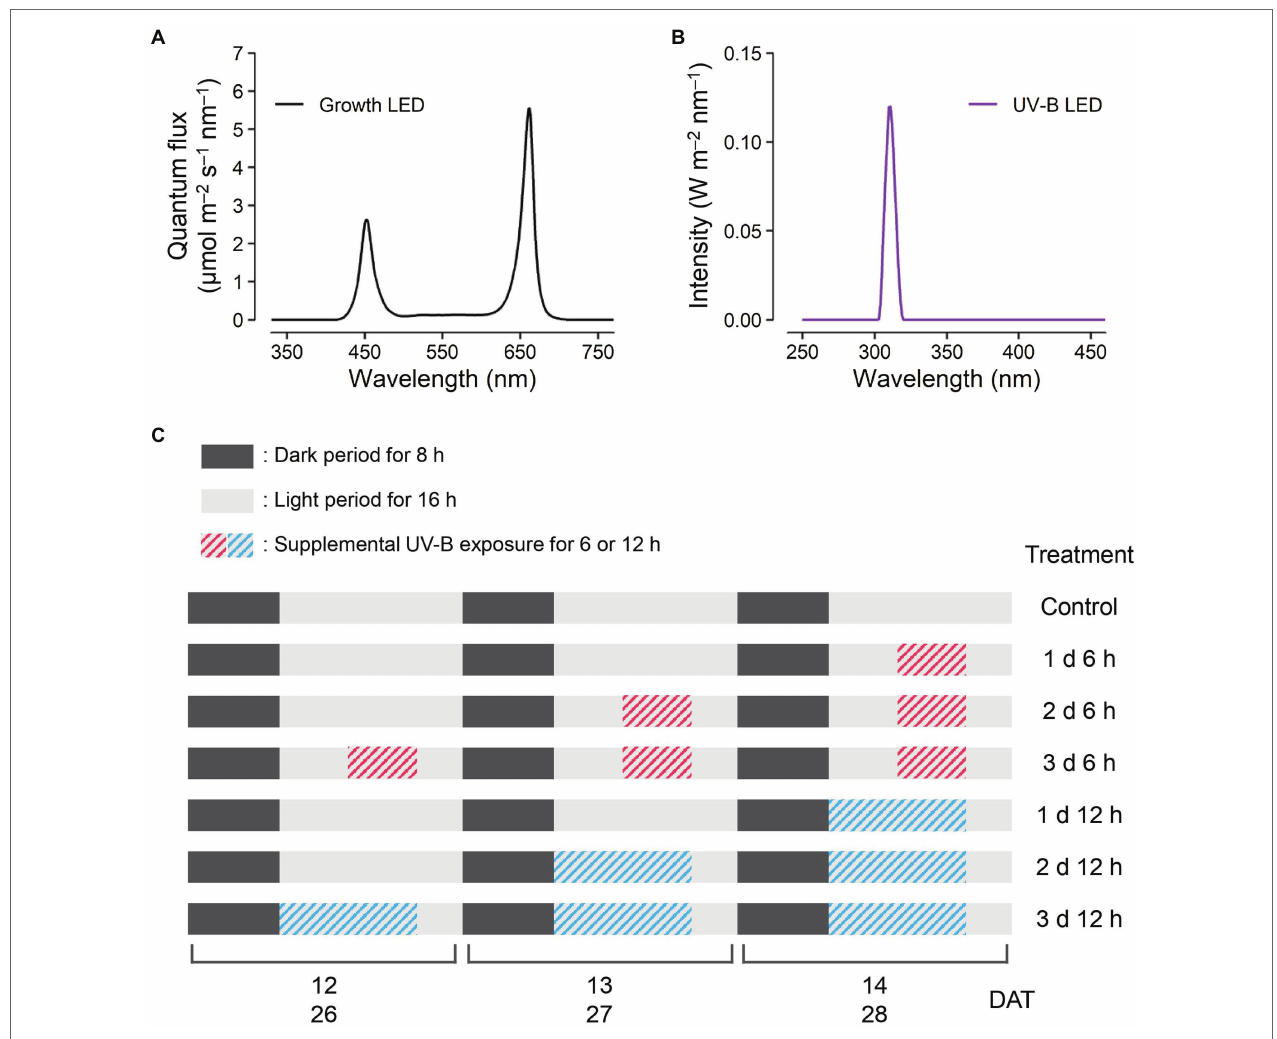
FIGURE 1 | Experimental design. Light spectra of the red, blue, and white light-emitting diodes (LEDs) for plant growth (A) at 200 μ mol m − 2 s − 1 over a waveband of 400–700 nm and UV-B LED (B) of 1.2 W m − 2 at a spectrum peak of 310 nm. The schedules of UV-B treatments (C) consisting of supplemental UV-B exposures of 6 and 12 h per day for 1, 2, and 3 days before harvest were the same for both harvest dates at 14 and 28 days after transplanting